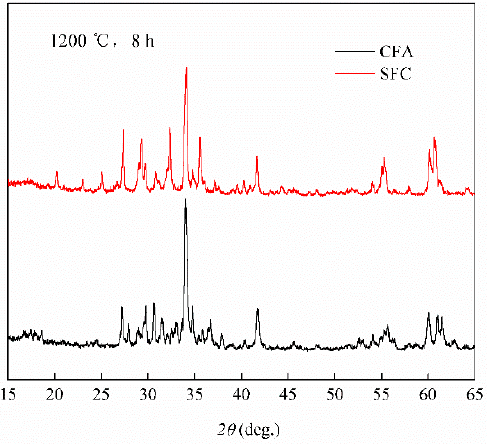
Figure 3. XRD patterns of SFC and CFA sintered at 1200 °C for 8 h.